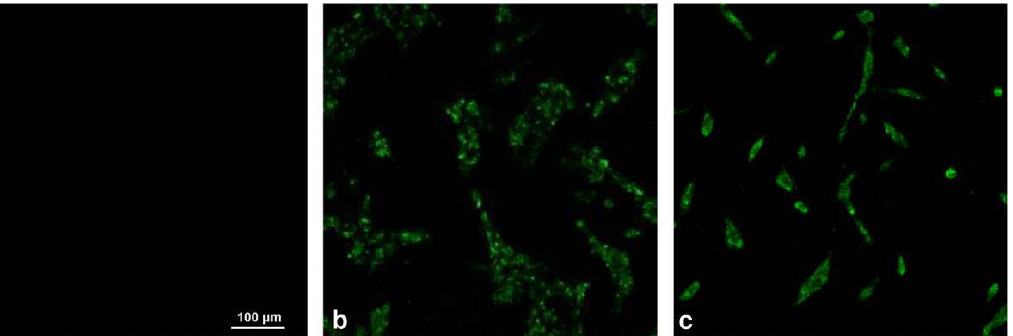
Figure 2. Viral immunofluorescence assay identification (×400). ( a ) Negative control. ( b ) XJ21032-1 isolate. ( c ) XJ20055-3 isolate.